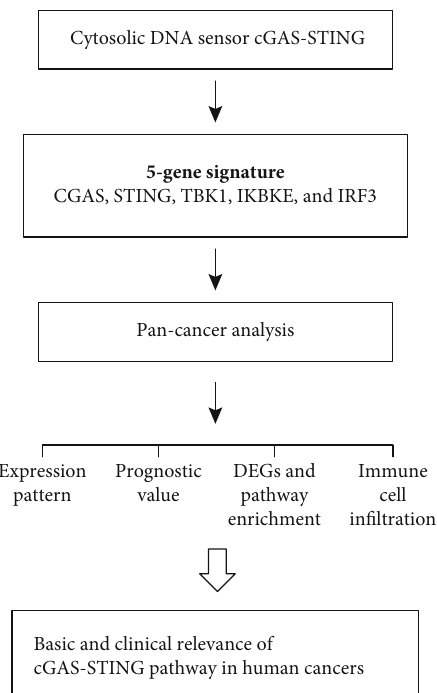
Figure 1: Graphic abstract for the cGAS-STING pathway and method fl